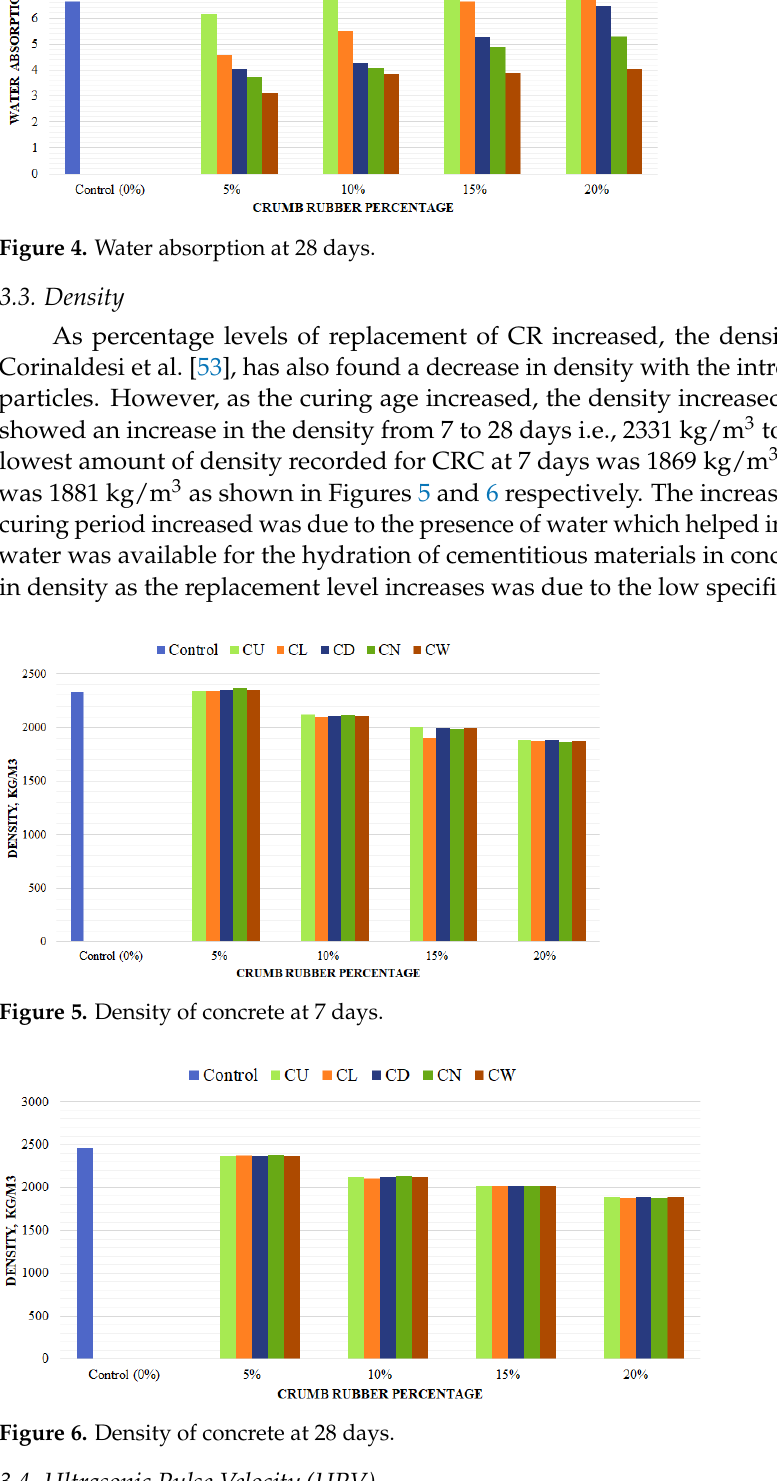
Figure 3. Water absorption at 7 days.